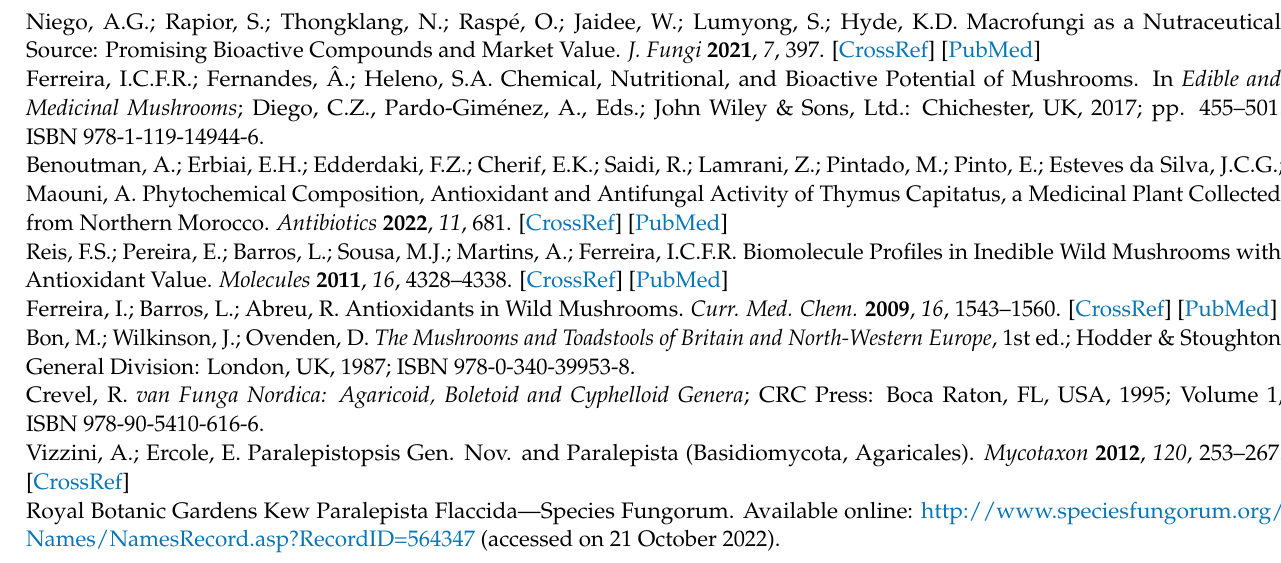
Table S3: Amino acids of the derivatized methanolic extract by GC–MS, Table S4: Organic acids of the derivatized methanolic extract by GC–MS analysis, Table S5: Rest of the biomolecule constituents of the derivatized methanolic extract by GC–MS analysis, Figure S3: Radical-scavenging activity on DPPH radicals. Each value is expressed as mean ± SD (n = 3), Figure S4: Lipid peroxidation inhibition measured by the β -carotene bleaching inhibition. Each value is expressed as mean ± SD (n = 3), Figure S5: Reducing power. Each value is expressed as mean ± SD (n =